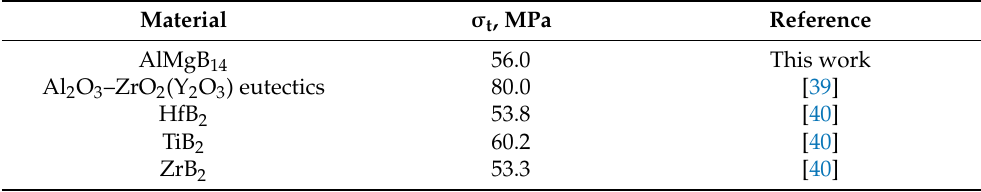
Table 5. Comparison of the tensile strength of AlMgB 14 with other